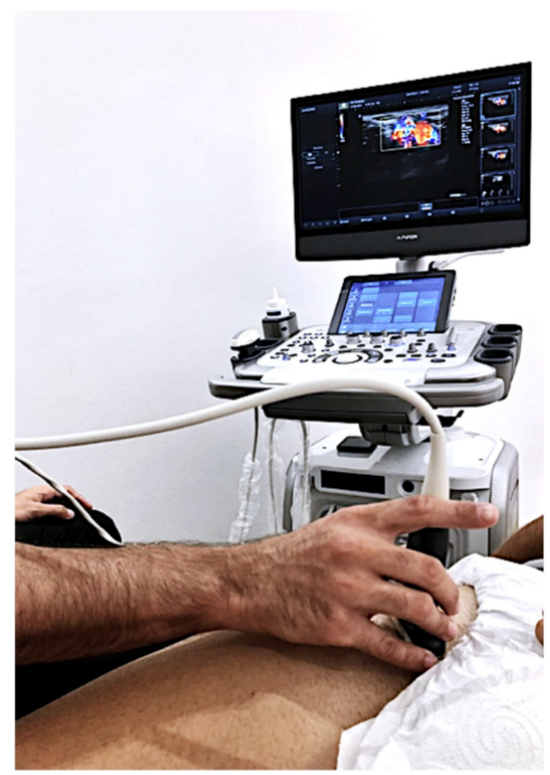
Figure 2. Pulsed Doppler exam.